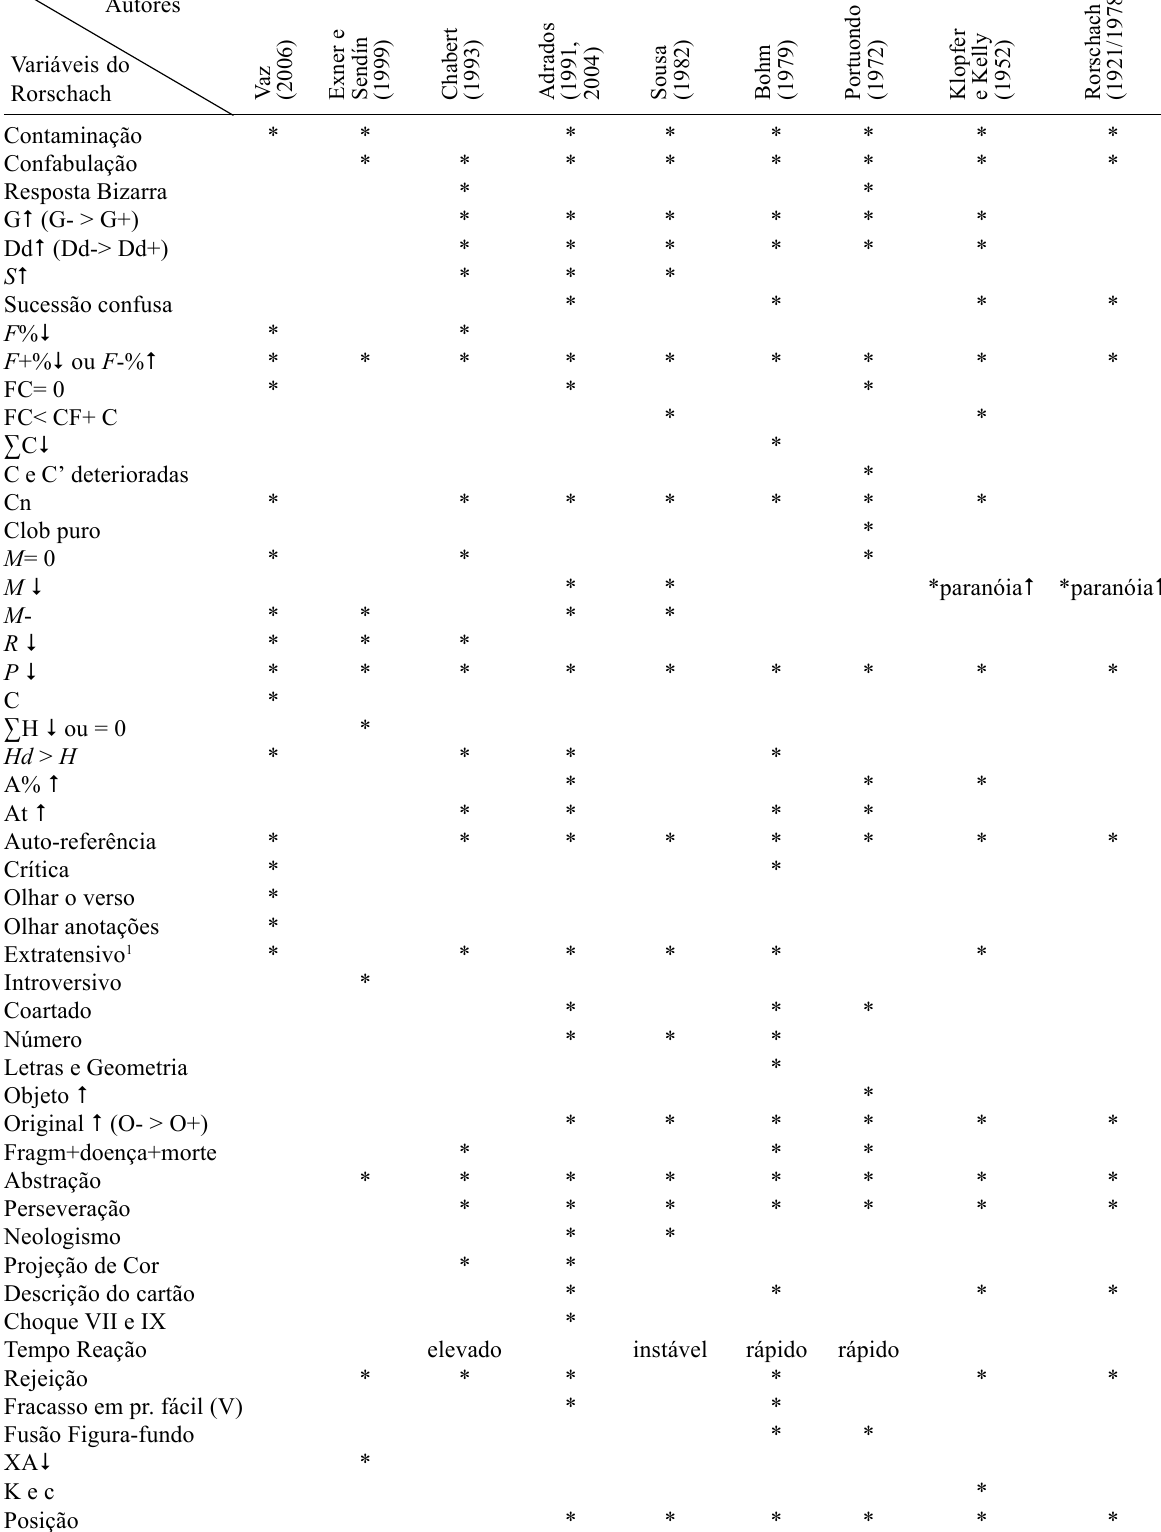
Notas . Fontes consultadas: I. Adrados (1991, pp. 150-155 e 2004, pp. 24-48), E. Bohm (1979, p. 336-338), C. Chabert (1993, pp. 115-116 e 135-145), J. E. Exner e C. Sendín (1999, p. 50), B. Klopfer e D. Kelly (1952, pp. 252-270), A. J. Portuondo (1972, pp.